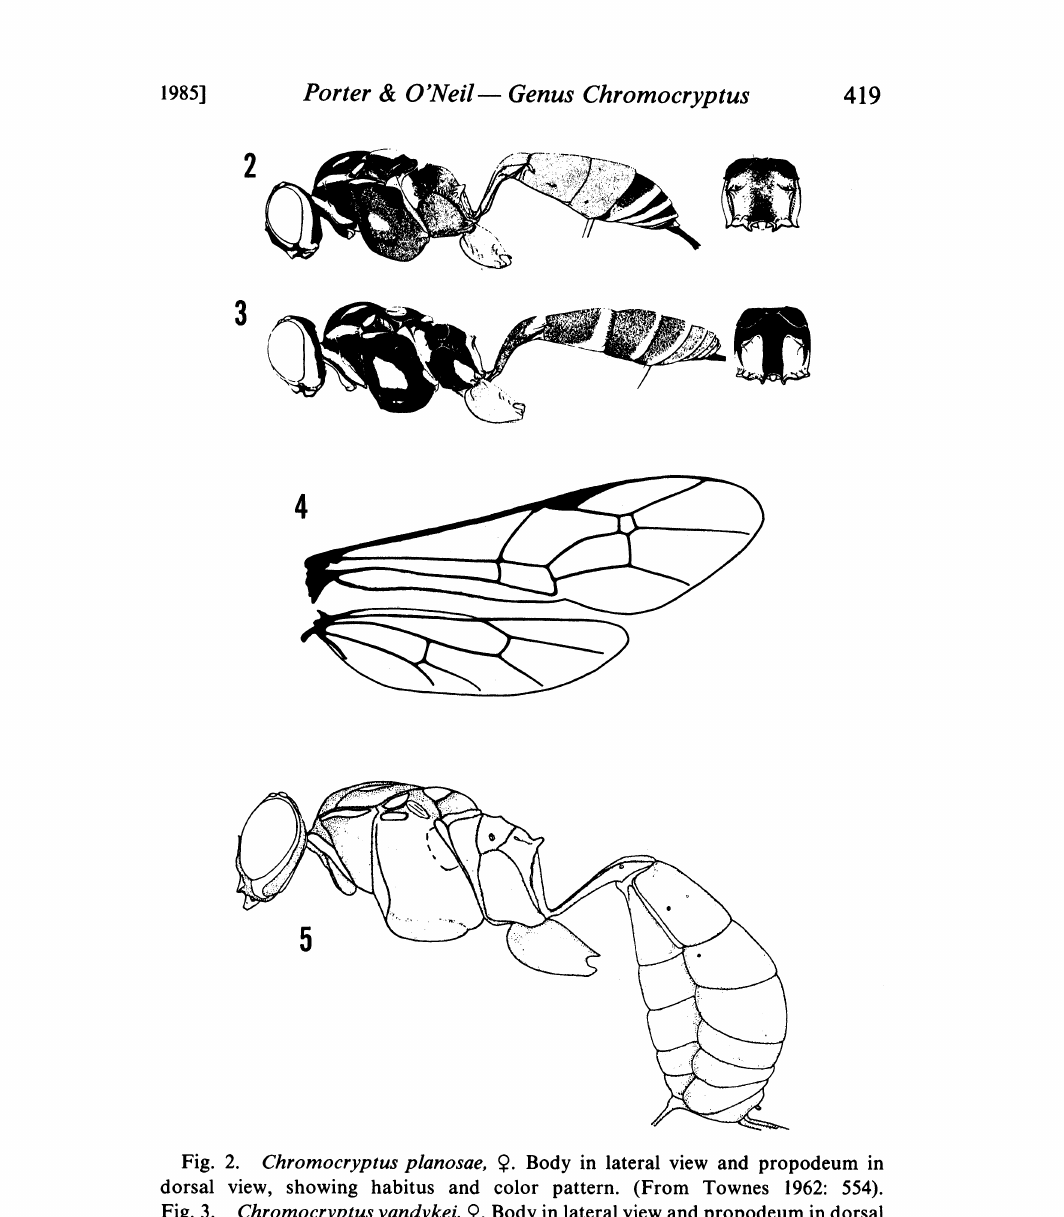
. . Fig. 2. Chromocryptus planosae, Body in lateral view and propodeum in . dorsal view, showing habitus and color pattern. (From Townes 1962: 554). . Fig. 3. Chromocryptus vandykeL Body in lateral view and propodeum in dorsal view, showing habitus and color pattern. (From Townes 1962: 554). Fig. 4. Chromocryptus huebrichi, Wings. (From Porter 1967: Fig. 71). Fig. 5. Chro- H olotype. Lateral view of body showing habitus and color mocryptus weemsL pattern. (From Porter 1974: